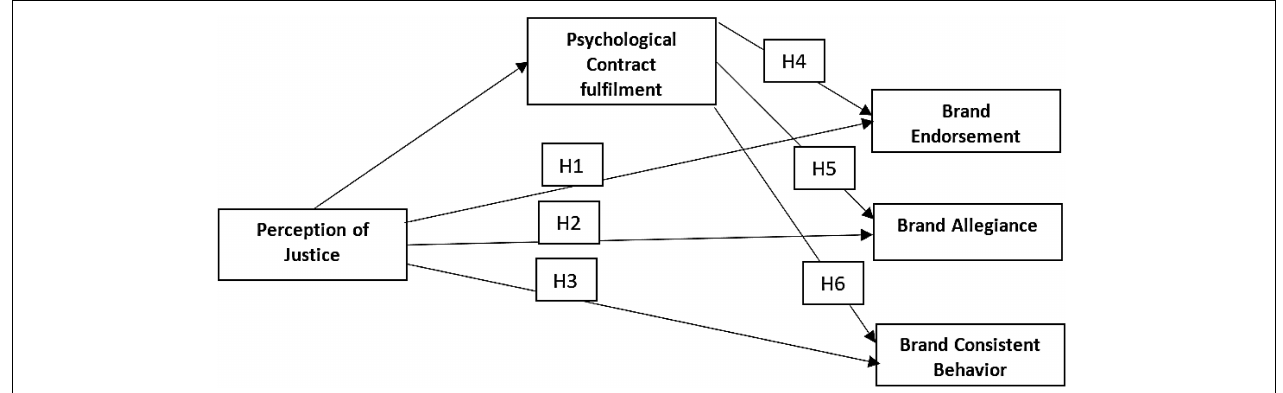
FIGURE 1 | Conceptual